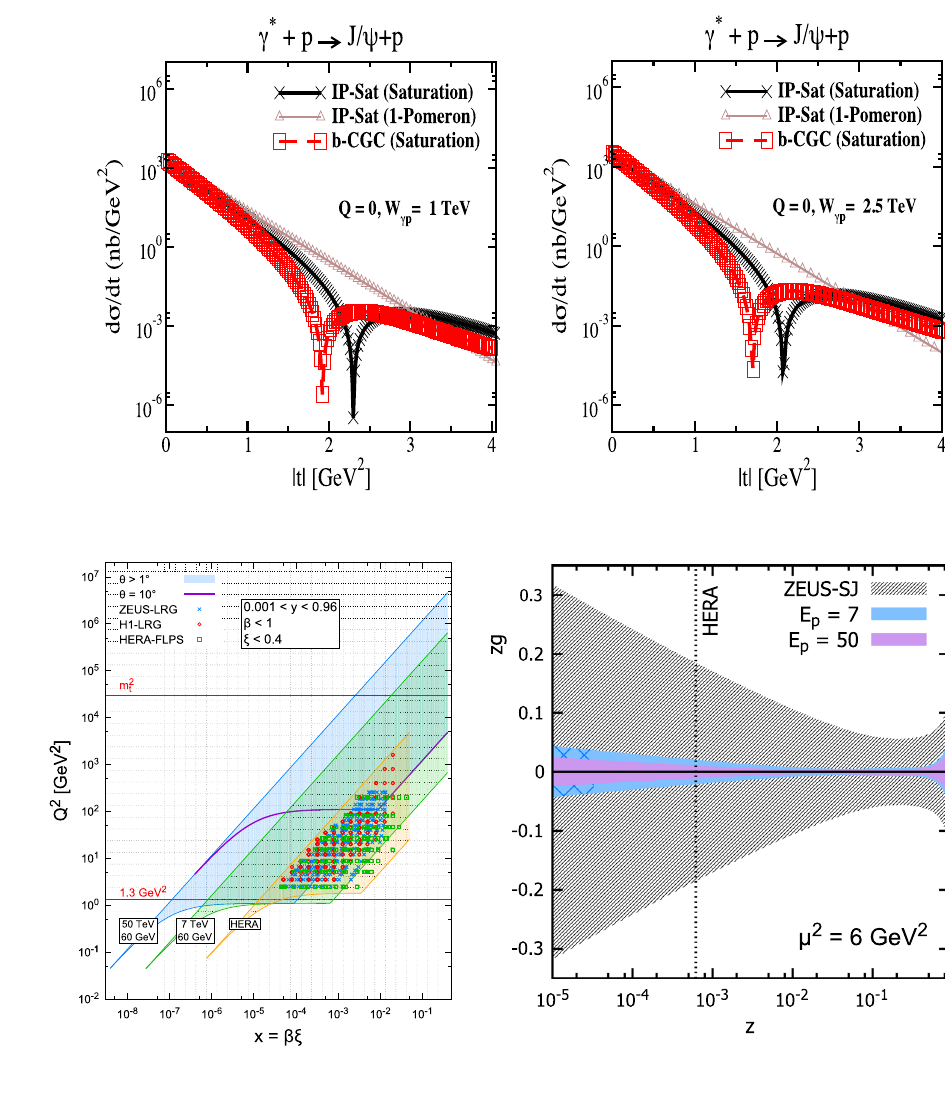
Fig. 5.16 Differential cross section as a function of momentum transfer | t | for the elastic J /(cid:25) photoproduction. Left W = 1TeV, right W = 2 . 5TeV